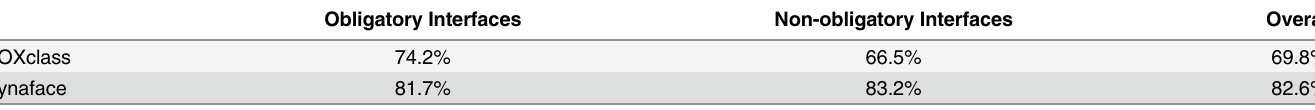
Table 2. The success rate of NOXclass and DynaFace for the binary complexes in the set of S1